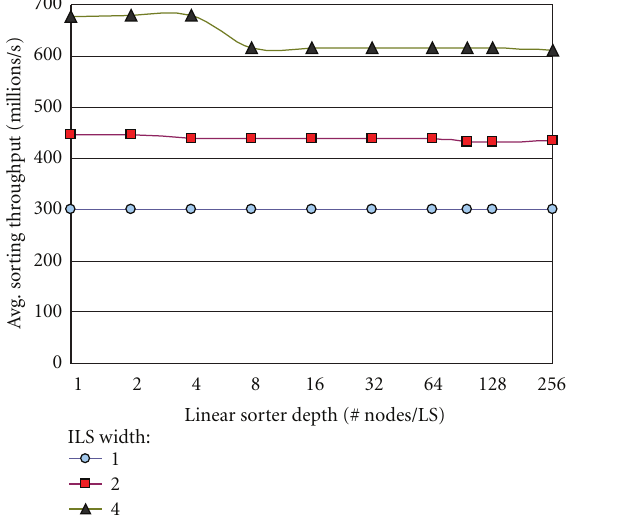
Table 7: Superscalar and reorder bu ff er